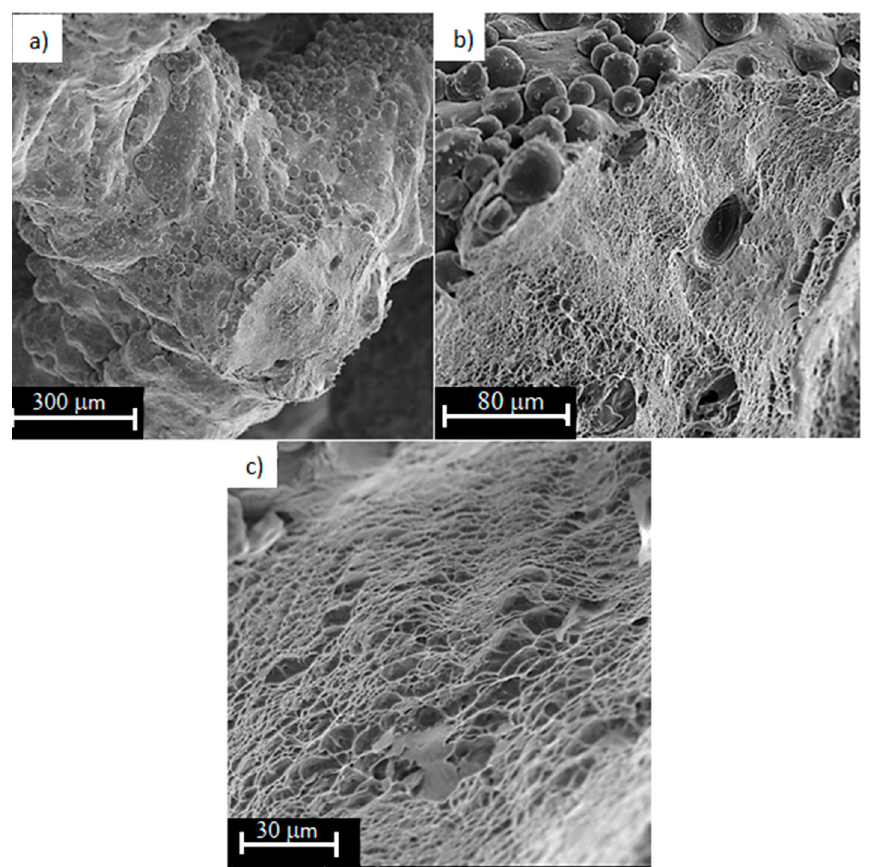
Figure 11. Fracture surfaces of Ti6Al4V titanium alloy with 73% porosity, subjected to a monotonic tensile test (magnification: ( a ) 250×; ( b ) 1000×; ( c ) 2000×).